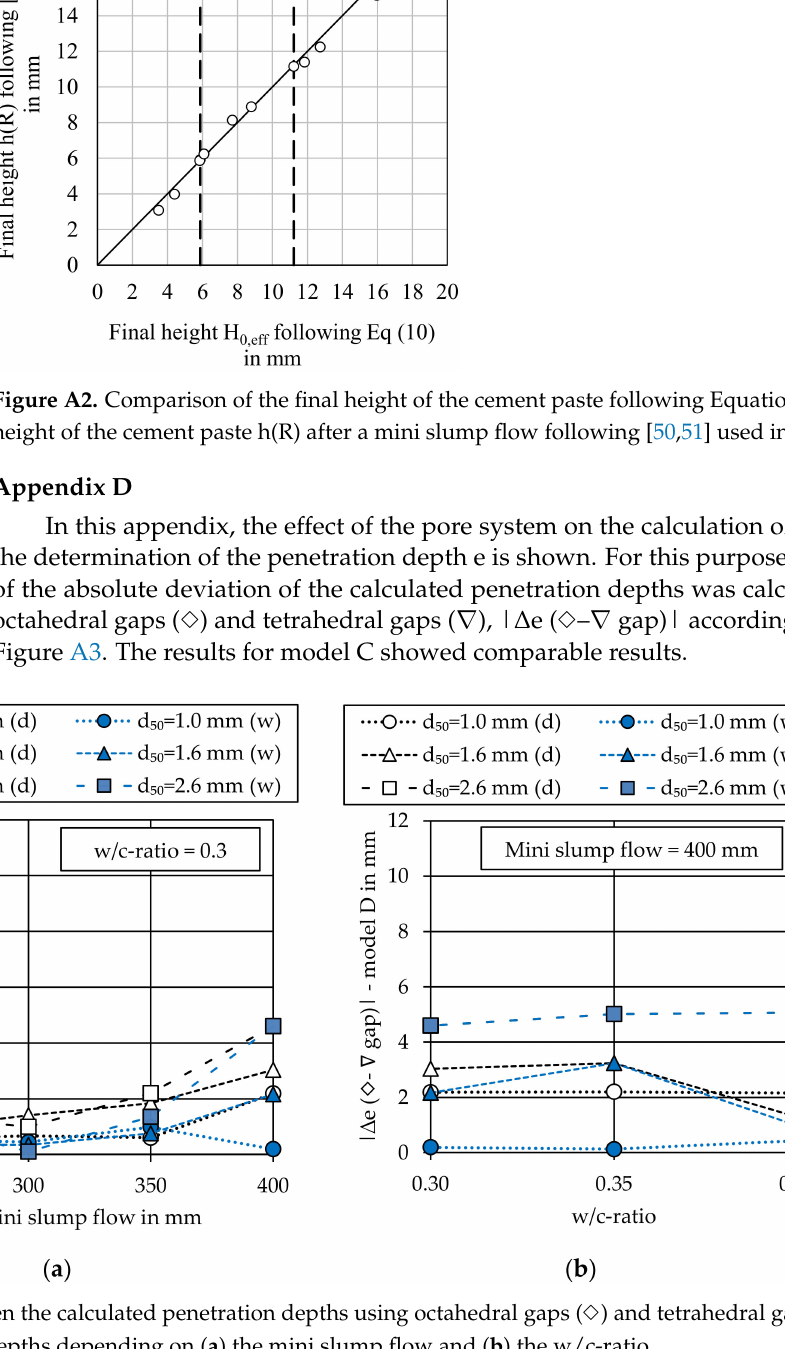
) and tetrahedral gaps ( ∇ ) to the (cid:51)